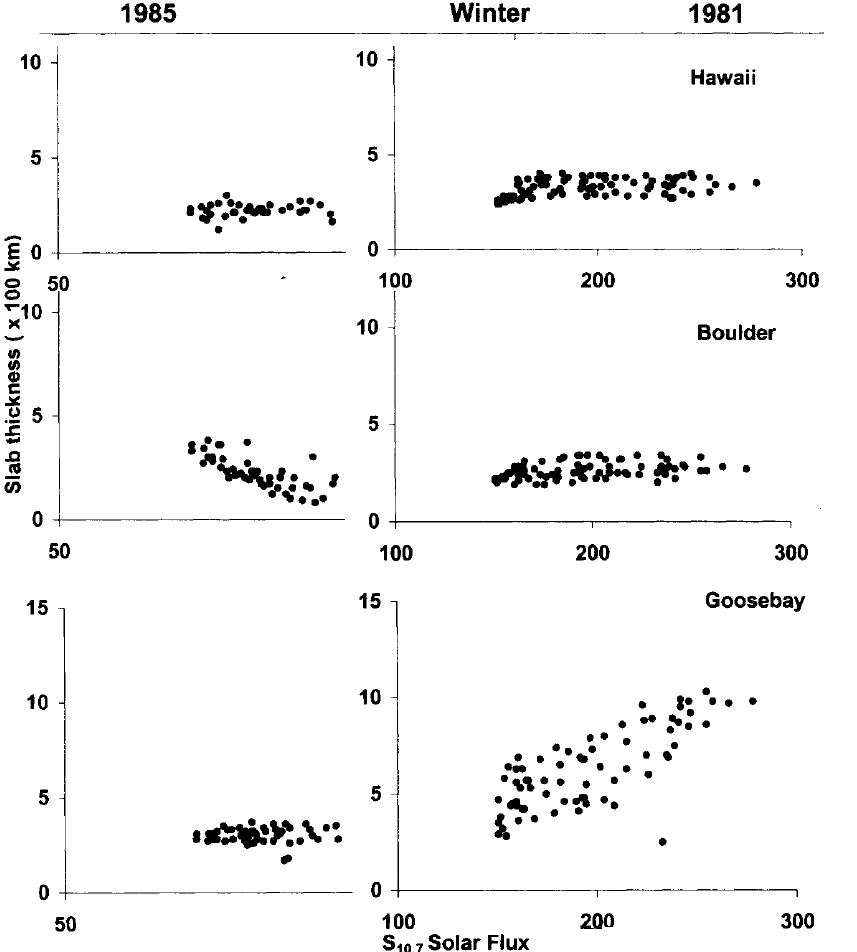
Fig. 3. Solar activity variation of slab thickness for Hawaii, Boulder and Goosebay during the winter season of solar maximum and minimum